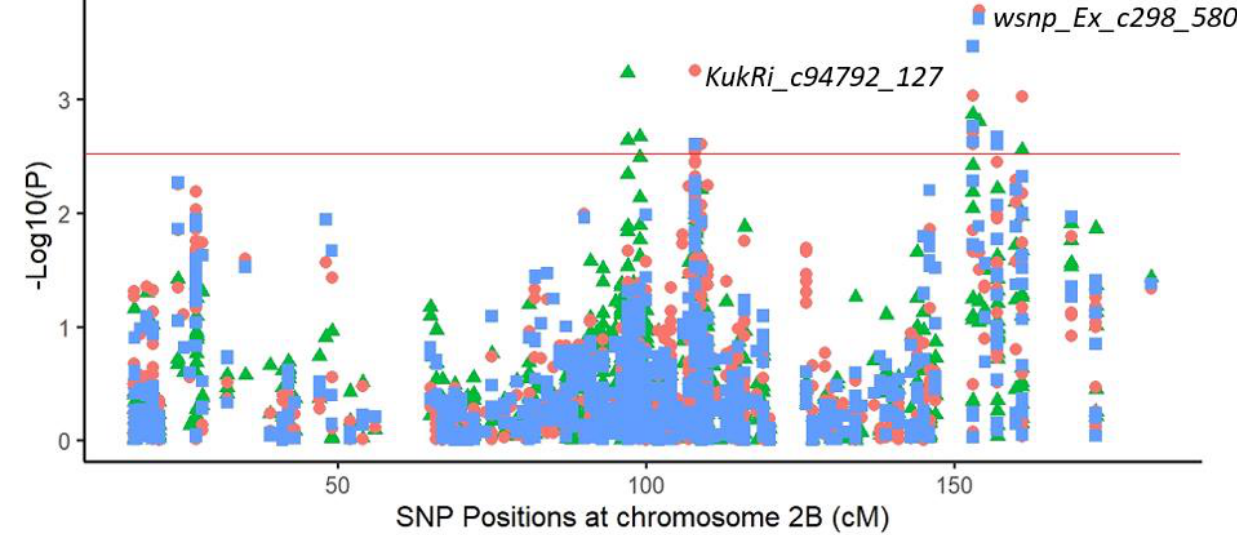
Figure 3. Genome-wide association study results using 940 single nucleotide polymorphism (SNP) markers on chromosome 2B in a 197 spring bread wheat population, showing pleiotropic effects for grain yield (triangle), biomass (dots) and grain number (square) in the Sidi El Aidi station. The horizontal line shows the −log10 ( p ) = 2.5 threshold.